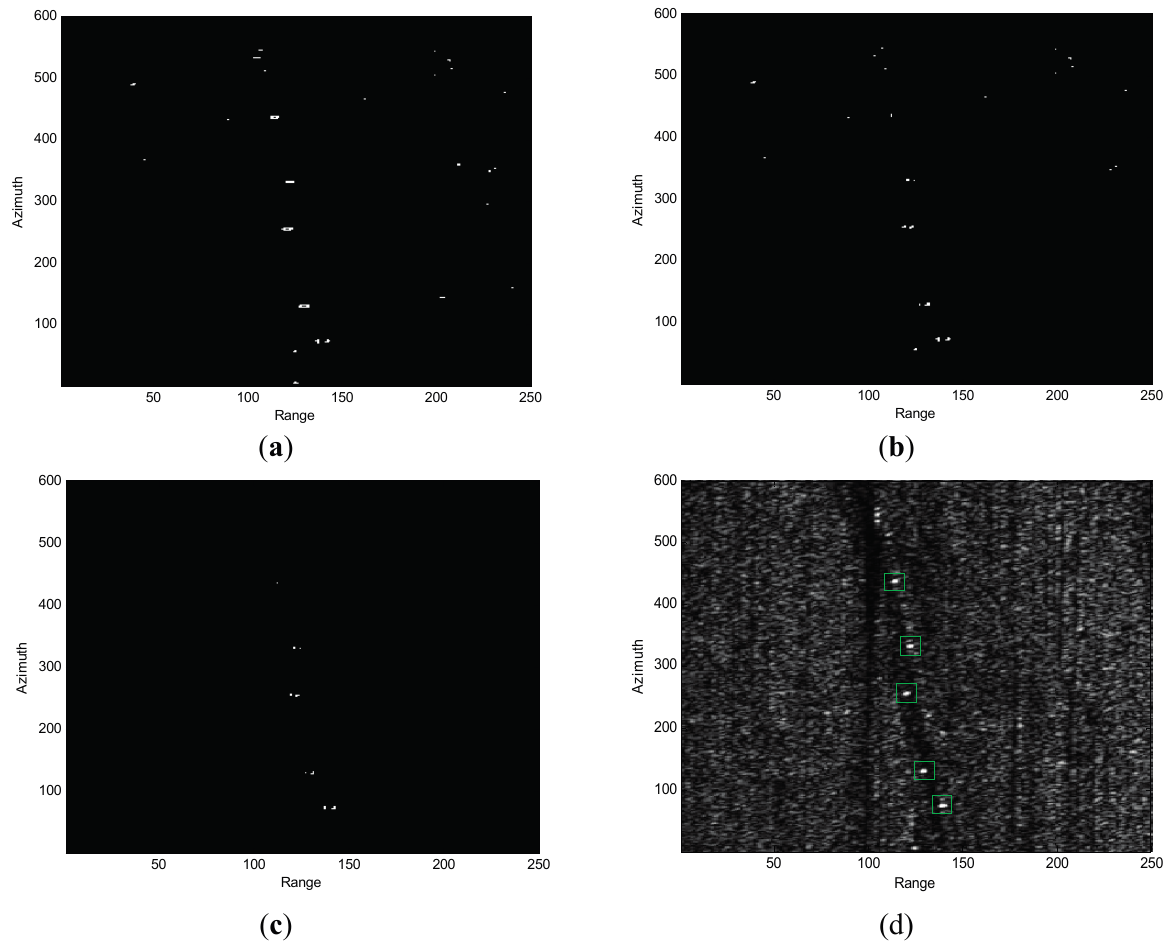
Figure 8. Detection results of the proposed method: ( a ) Binary output with the detection contour line; ( b ) Binary results after applying the phase filters; ( c ) Results after applying the magnitude filter; ( d ) Detection results corresponding to the original SAR